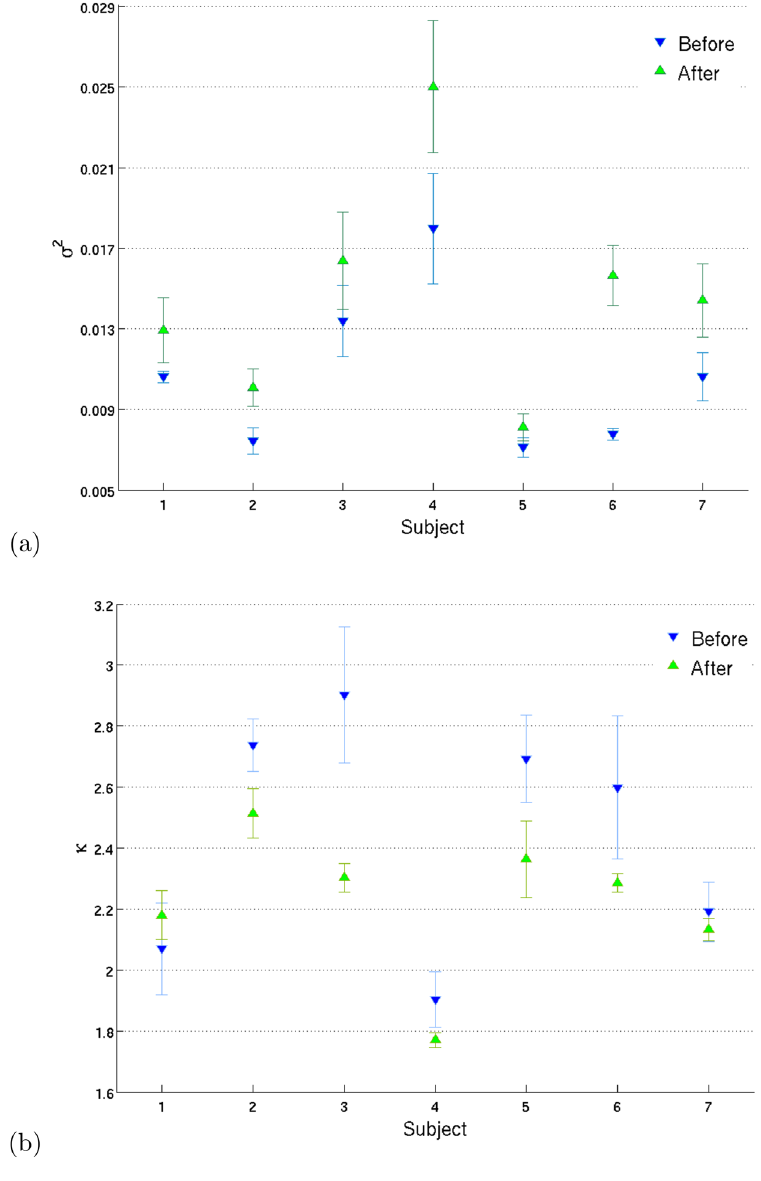
16 networks of the degree variance ( a ) and kurtosis ( b ), shown for each subject (blue ∇ ) and after (green Δ ) Ayahuasca ingestion. The individual values for the degree variance and kurtosis are calculated separately for each network. We find higher variance and (mostly) lower kurtosis after Ayahuasca, hence the node distributions change shape and become less “peaked”. Such behavior is again consistent with (if not suggestive of) a higher Shannon entropy after